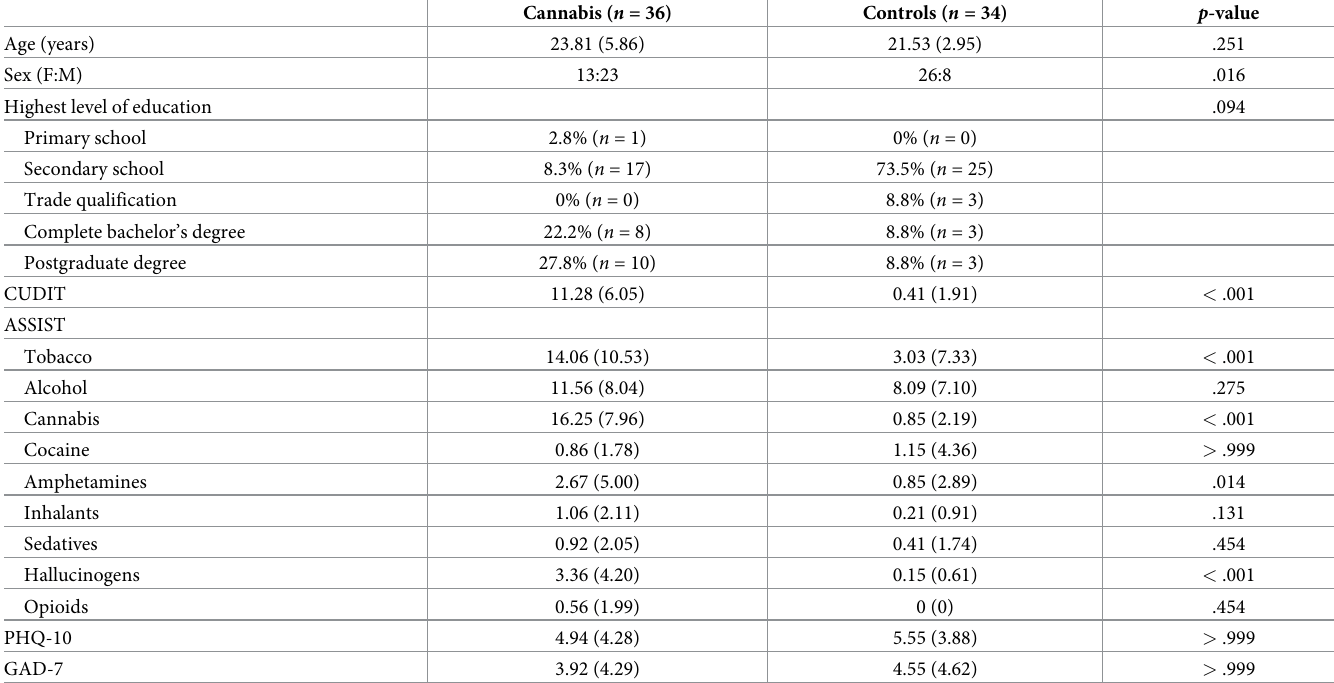
Table 1. Demographic and survey measures of drug use and mental